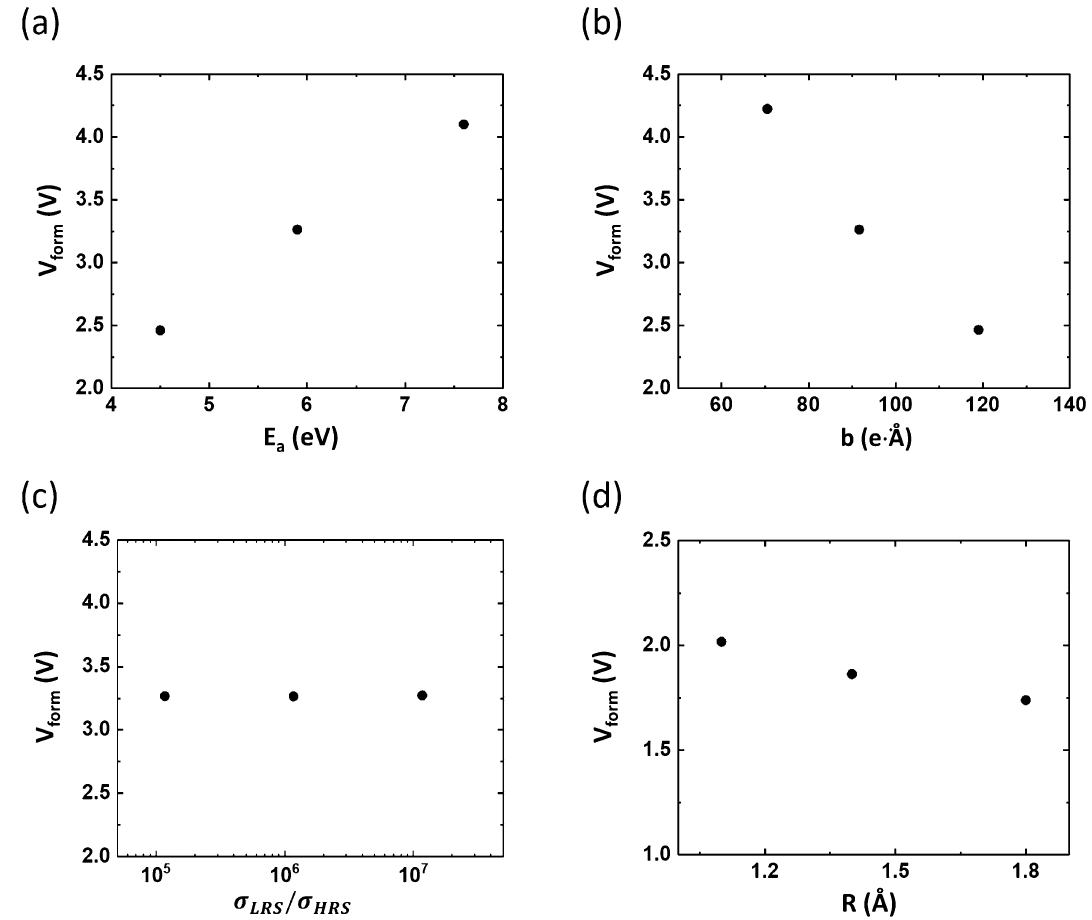
Figure 7. Material-parameter-dependence of forming voltage. ( a ) Defect formation energy, E a , ( b ) bond polarization factor, b , ( c ) ratio of low-resistance state (LRS)-to-high-resistance state (HRS) conductivities, σ LRS /σ HRS , and ( d ) defect radius, R . The insulator thickness for these simulations is 10 nm.